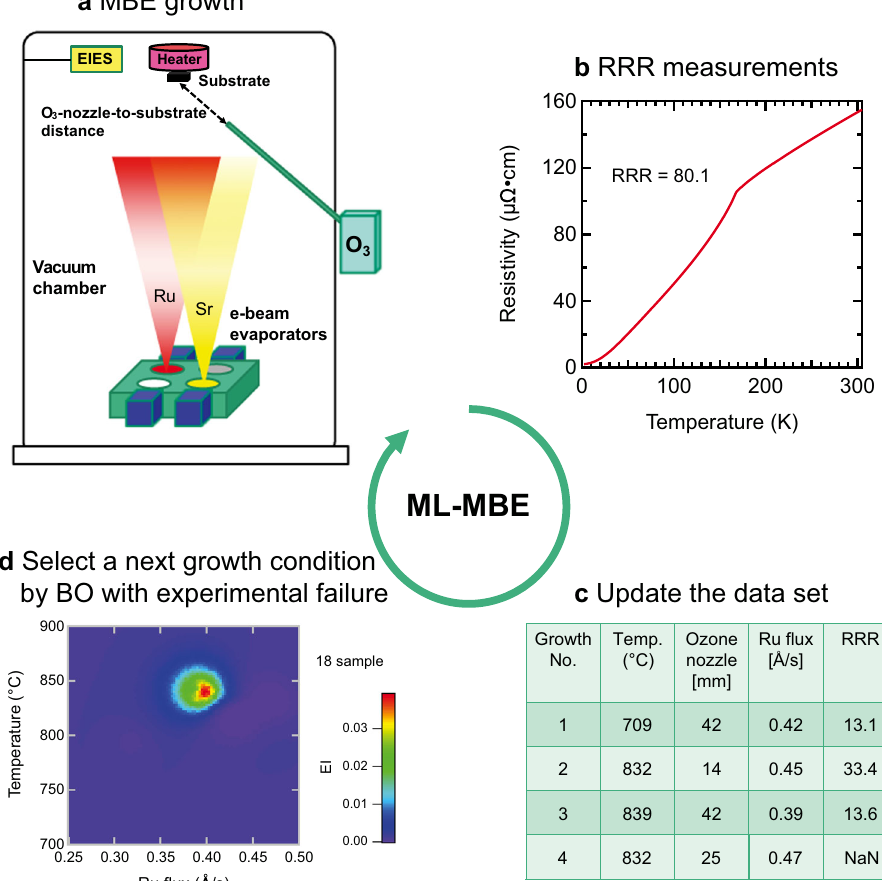
Fig. 5 Flow of ML-MBE growth using BO with experimental failure. a Schematic illustration of our multisource oxide MBE setup. EIES: Electron Impact Emission Spectroscopy. b Resistivity vs. the temperature curve of the SrRuO 3 /DyScO 3 fi lm with a RRR of 80.1, as an example. c Growth conditions for four samples, as an example. d Two-dimensional plots of EI values at the O 3 -nozzle-to-substrate distance of 22.5 mm obtained from the collected data for 18 samples, as an